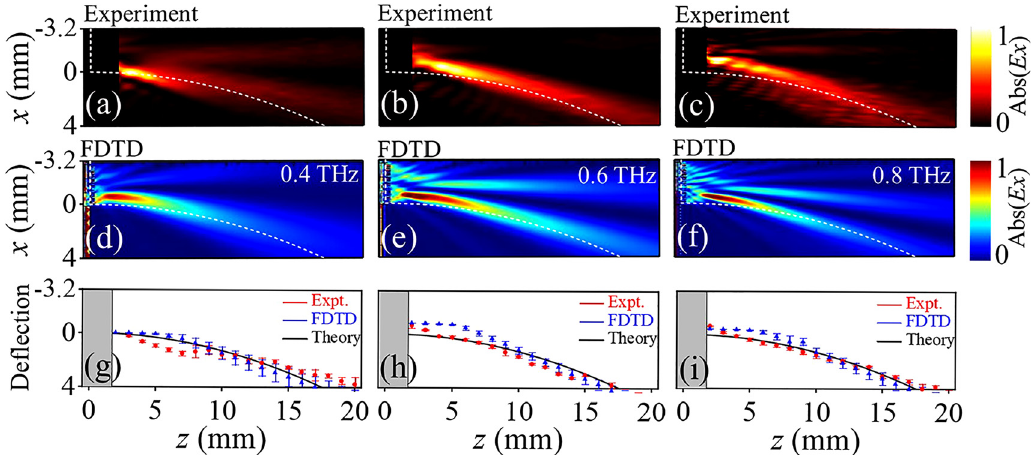
Figure 5: Achromatic Airy beam experiments. (a) – (c) Experimental results on near-field detections at the three frequencies, showing that the intensity distributions of the left circular polarization (LCP) field transmitted through the metasurface devices match well with the white dash line indicating the parabolic trajectory. (d) – (f) Simulation results at the three frequencies. (g) – (i) Comparison of experiment, simulation, and theoretical deflections, where the error bars correspond to 95% of the maximum normalized